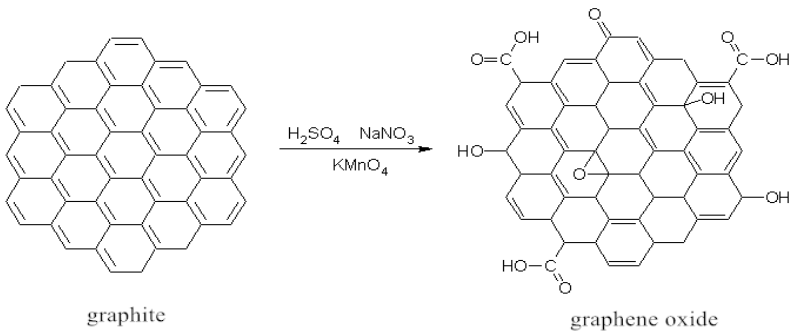
Figure 1. Reaction mechanism for synthesis of graphene oxide.